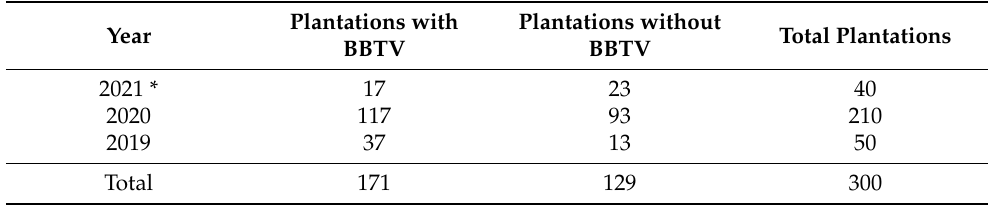
Table 9. Summary of banana field sites surveyed for the occurrence of BBTV in the Idologun region of Ogun State, Nigeria .